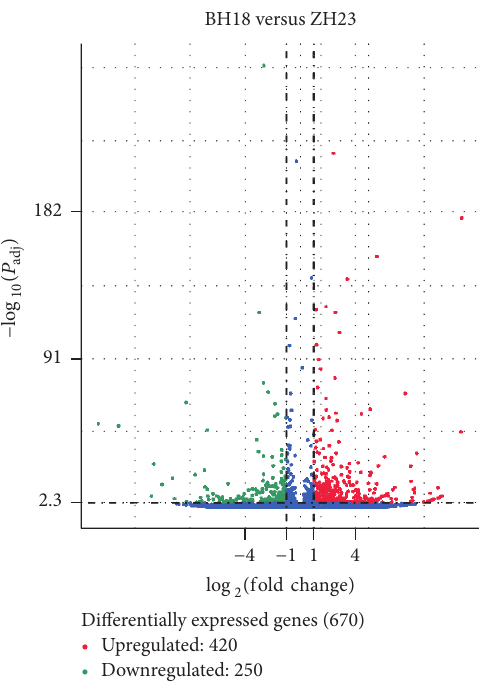
Figure 3: Comparison of expression patterns of differential uni- genes identified between BH18 and ZH23. The red dots repre- sent upregulated DEGs, the green dots represent downregulated DEGs, and the blue dots represent non-DEGs. In total, 670 uni- genes were identified as differentially expressed genes ( 𝑄 value < 0.005 and log 2 (fold change) > 1) between BH18 and